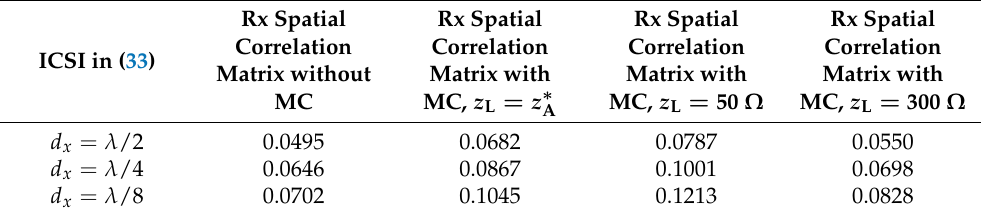
Figure 9. Eigenvalue magnitude versus eigenvalue index of the effective receive (Rx) spatial corre- lation matrix for horizontal element spacings of λ /2, λ /4, and λ /8 with a holographic RIS size of 4 λ × 4 λ , for both without and with MC cases. z L denotes the load impedance. Note that both the eigenvalue index and eigenvalue magnitude are dimensionless. Table 2. ICSI in (33) for Rx spatial correlation matrix without and with MC under various ele- ment